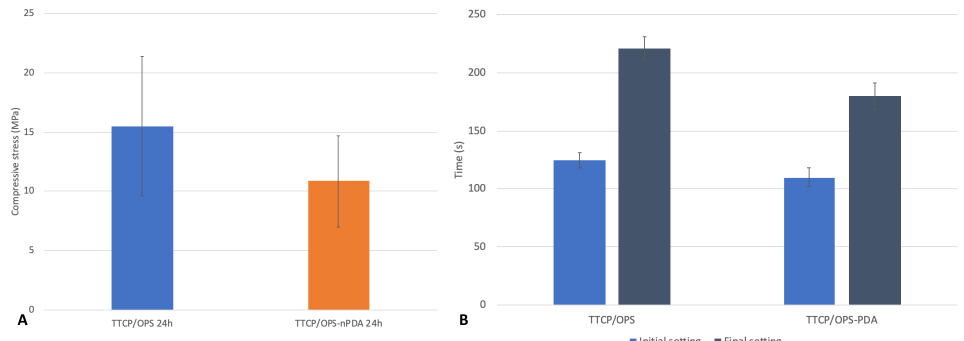
Figure 5. Characterization of the bone adhesive TTCP/OPS versus TTCP/OPS-nPDA: ( A ) com- pression test using cylinder glue samples after 24 h immersion in a 37 ◦ C PBS bath ( p = 0.083); ( B ) measuring the setting time by Gillmore test on disk glue